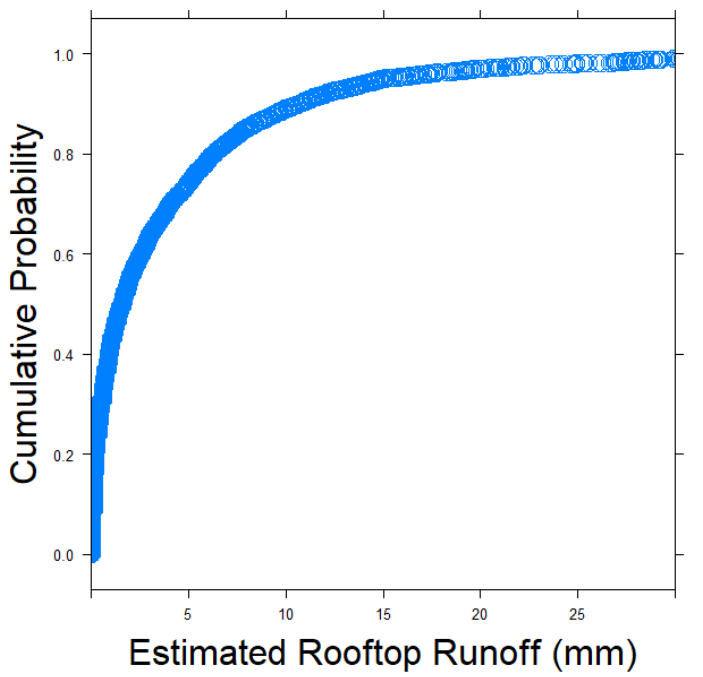
Figure 5. Cumulative probability that rooftop runoff was less than the estimated depth (mm).